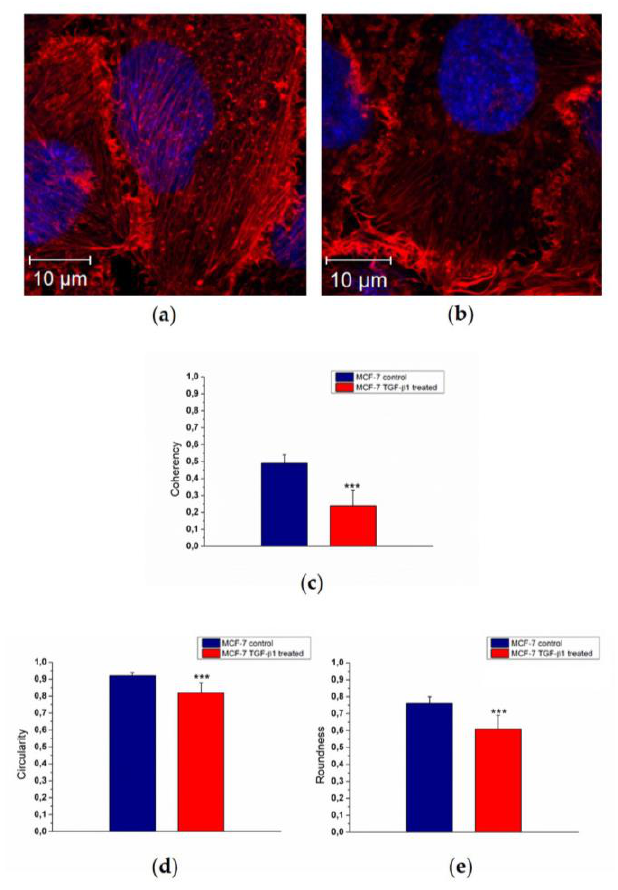
Figure 2. Representative confocal images of control MCF-7 cells (MCF-7 CTR ) ( a ) and treated ones (MCF-7 TGF-β1 ). MCF-7 TGF-β1 were treated with TGF-β1 (5 ng/mL) for 48 h. ( b ). F-actin is labeled in red and nuclei in blue. Acquisitions were performed by Zeiss LSM700 (Zeiss) confocal microscopy.